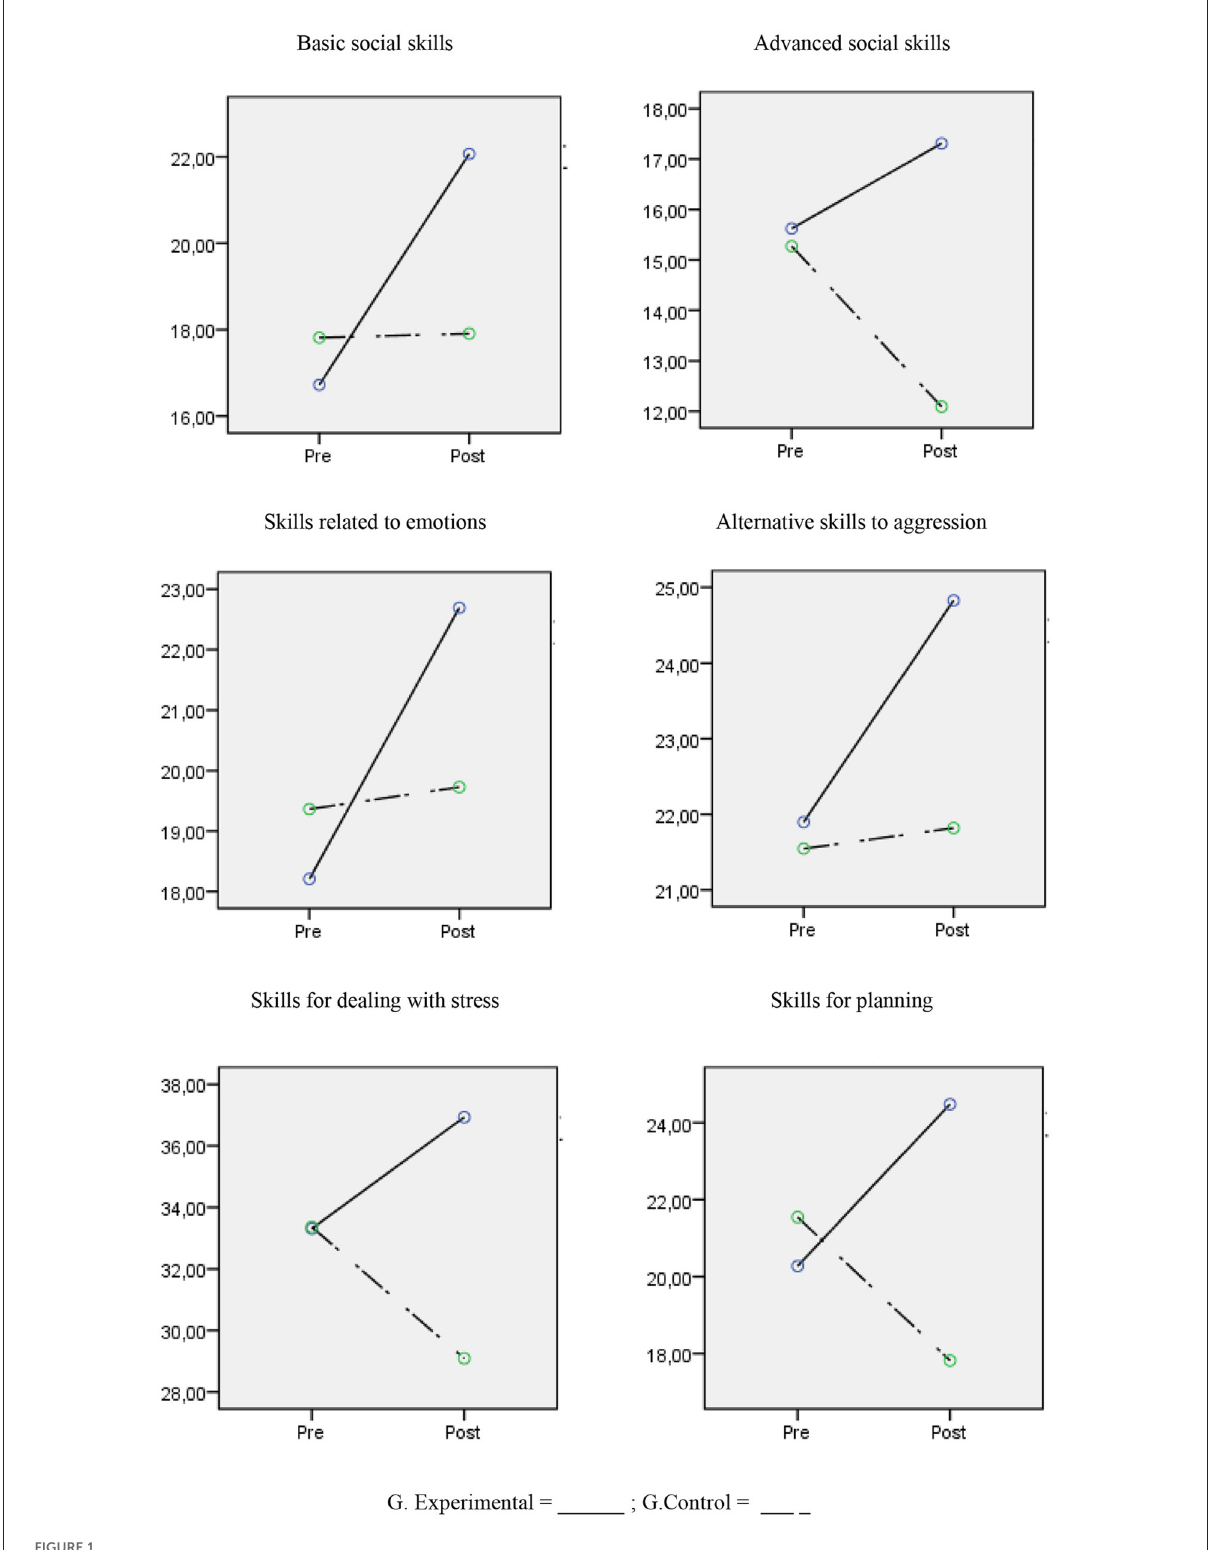
FIGURE1 Change in social skills scores between experimental and control